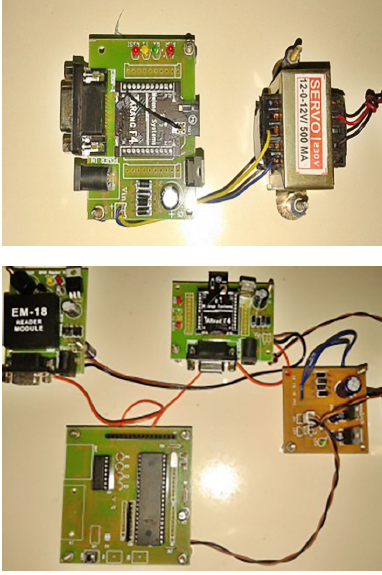
Figure 10. Cropped license